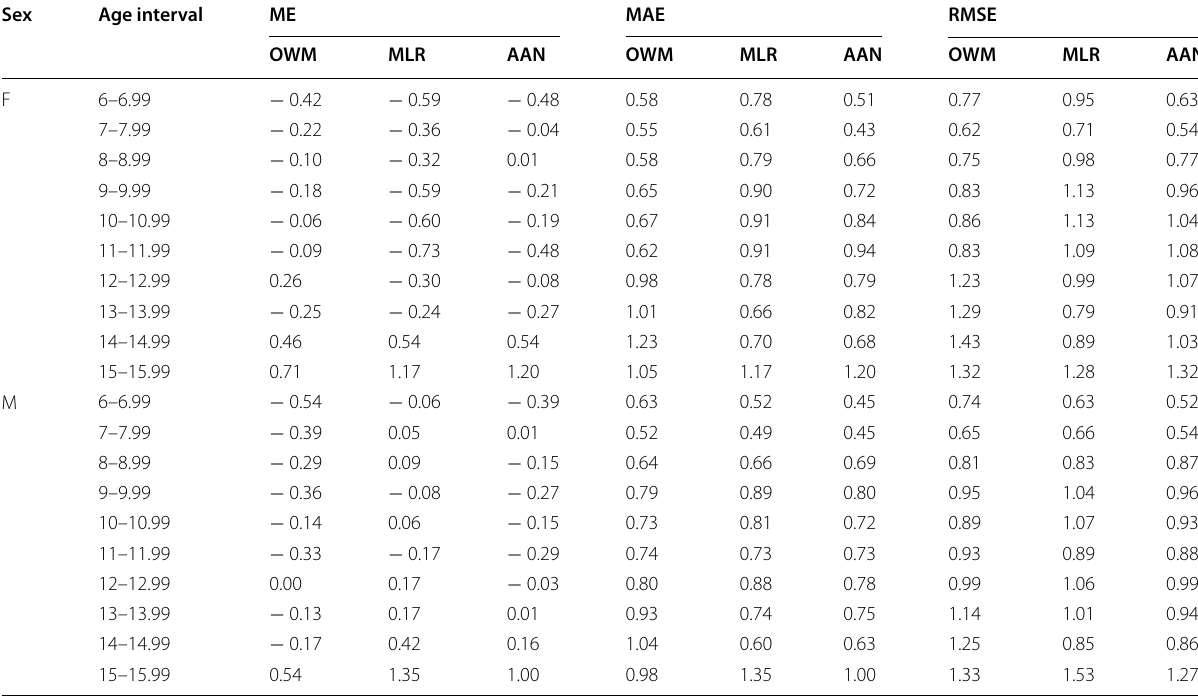
F females, M males, OWM original Willems model, MLR multivariate linear regression, ANN artificial neural network, ME mean error, MAE mean absolute error, RMSE root mean squared error Age interval expressed in years